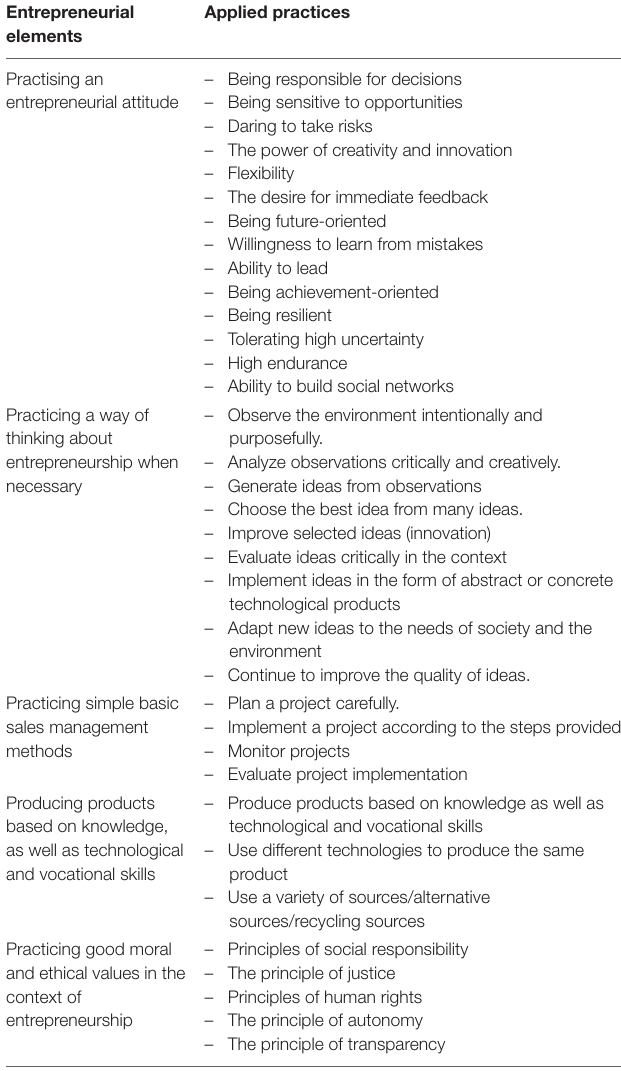
TABLE 1 | Entrepreneurial elements applied in teaching (Curriculum Development Division,